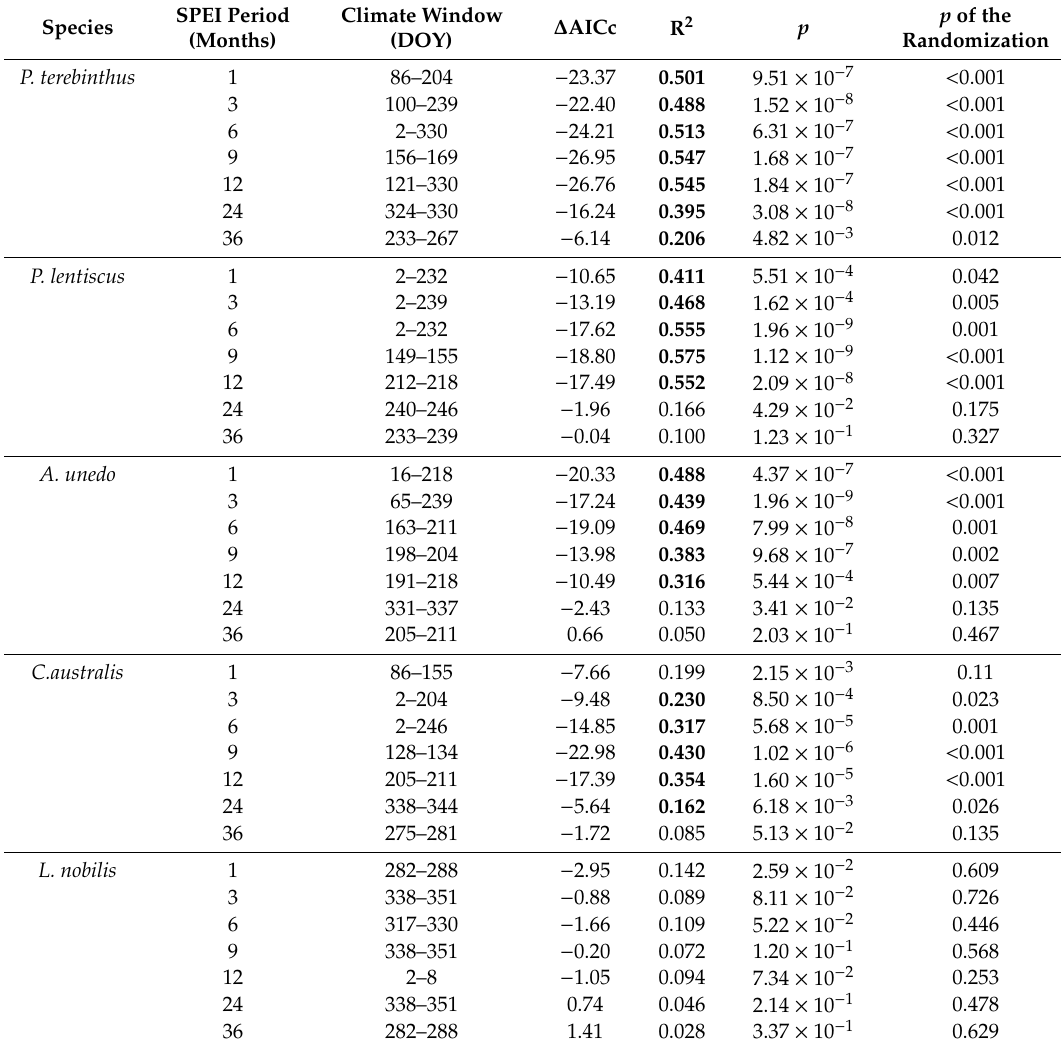
Table 4. Summary of the drought–growth relationships based on “ climwin” analyses and using the SPEI 7-day resolution data calculated at 1, 3, 6, 9, 12, 24, and 36 monthly periods. In all cases linear models and mean SPEI values were used. Significant ( p < 0.05) R 2 values are shown in bold characters. The abbreviation “DOY” stands for Julian day of the